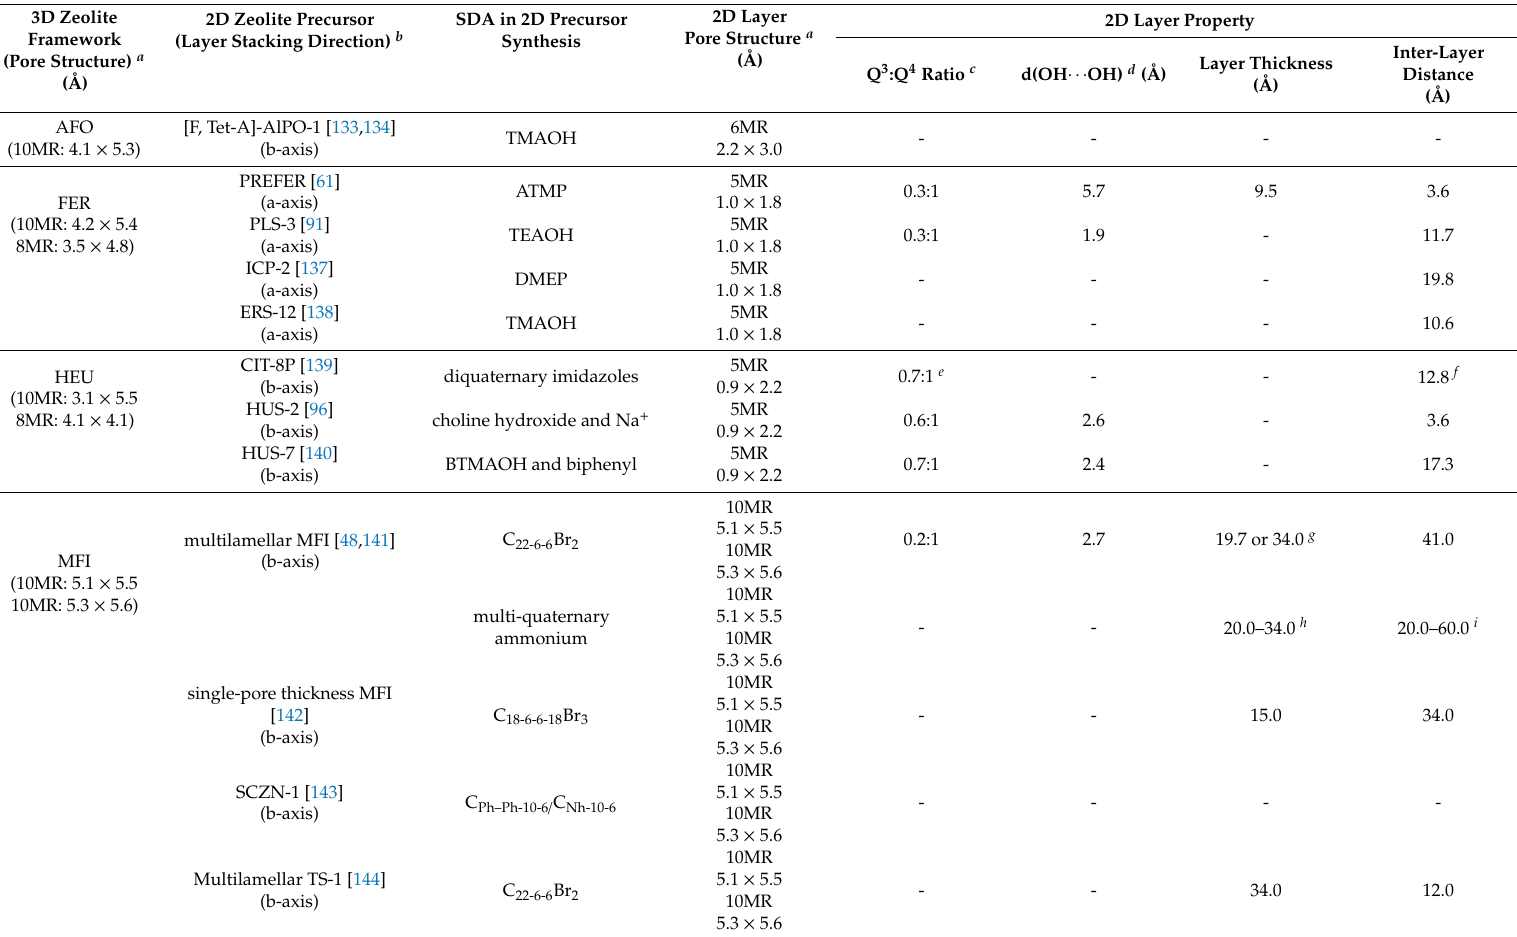
Table 4. Structural properties of 2D layered precursors and their related 3D (10-MR)